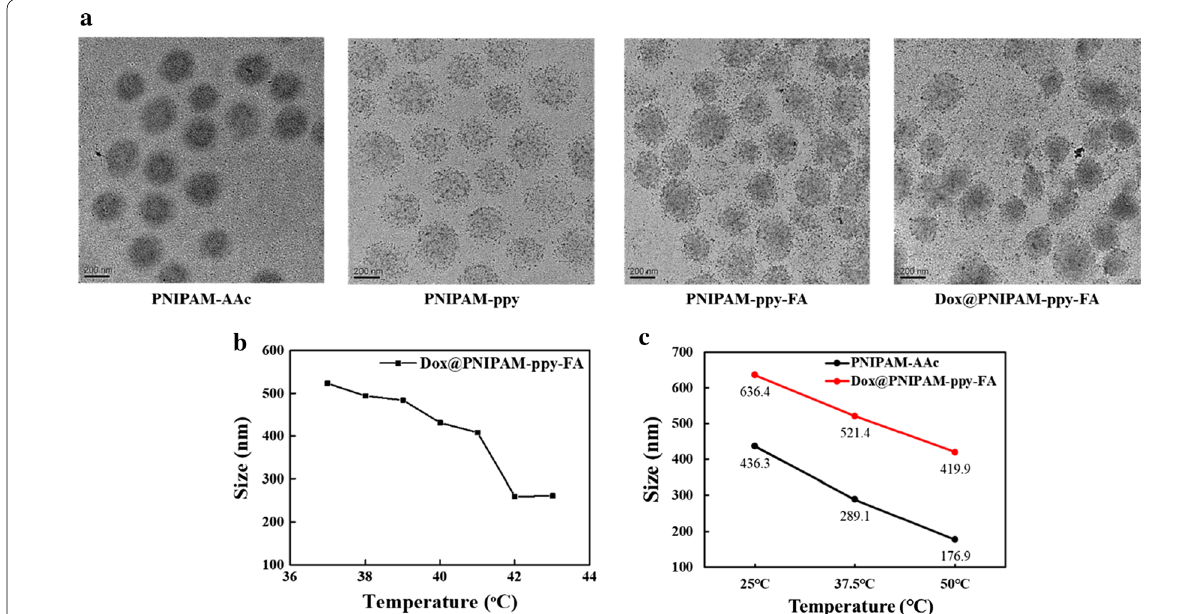
Fig. 1 a TEM images of PNIPAM-AAc, PNIPAM-ppy, PNIPAM-ppy-FA, and Dox@PNIPAM-ppy-FA nanocomposites. b LCST analysis of Dox@ PNIPAM-ppy-FA by DLS. c Average diameters of PNIPAM-AAc and Dox@PNIPAM-ppy-FA depending on different temperature conditions (at 25 °C, 37.5 °C, and 50